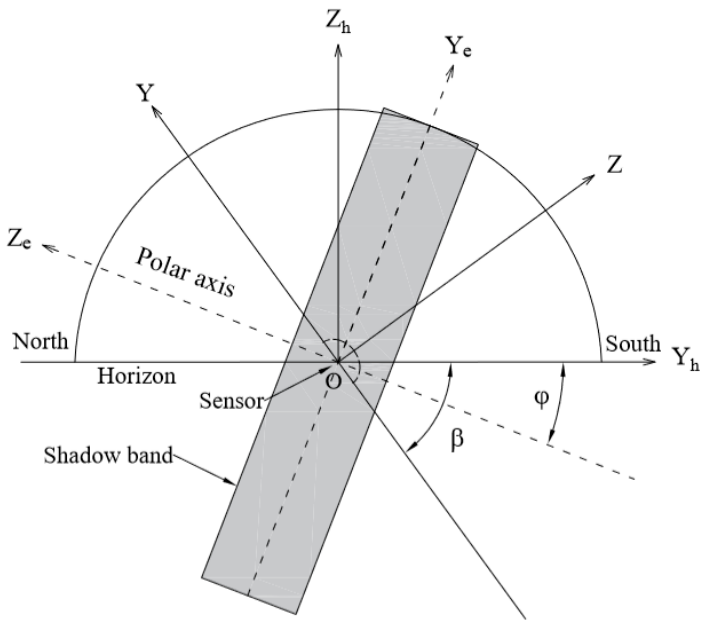
Figure 3. Diagram of shadow band placement in the equatorial coordinate system at δ = 0 .